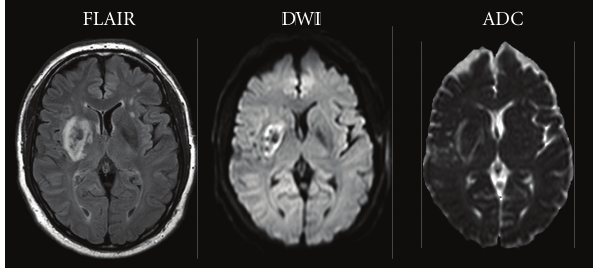
Figure 4: Case 1: follow-up MRI with FLAIR, DWI and ADC showing an established infarction in the right basal ganglia region, with minor hemorrhagic transformation, corresponding well to the previously defined CTP ischemic